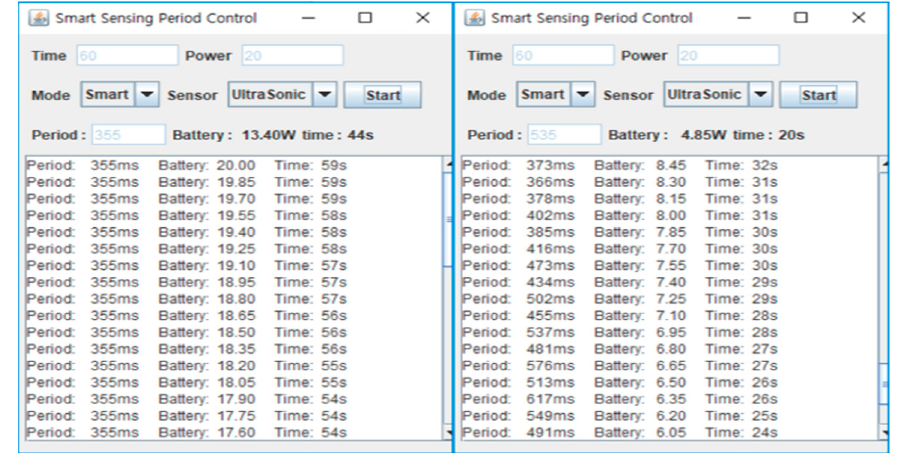
Figure 9. Screenshots of smart sensing in ultrasonic sensor.